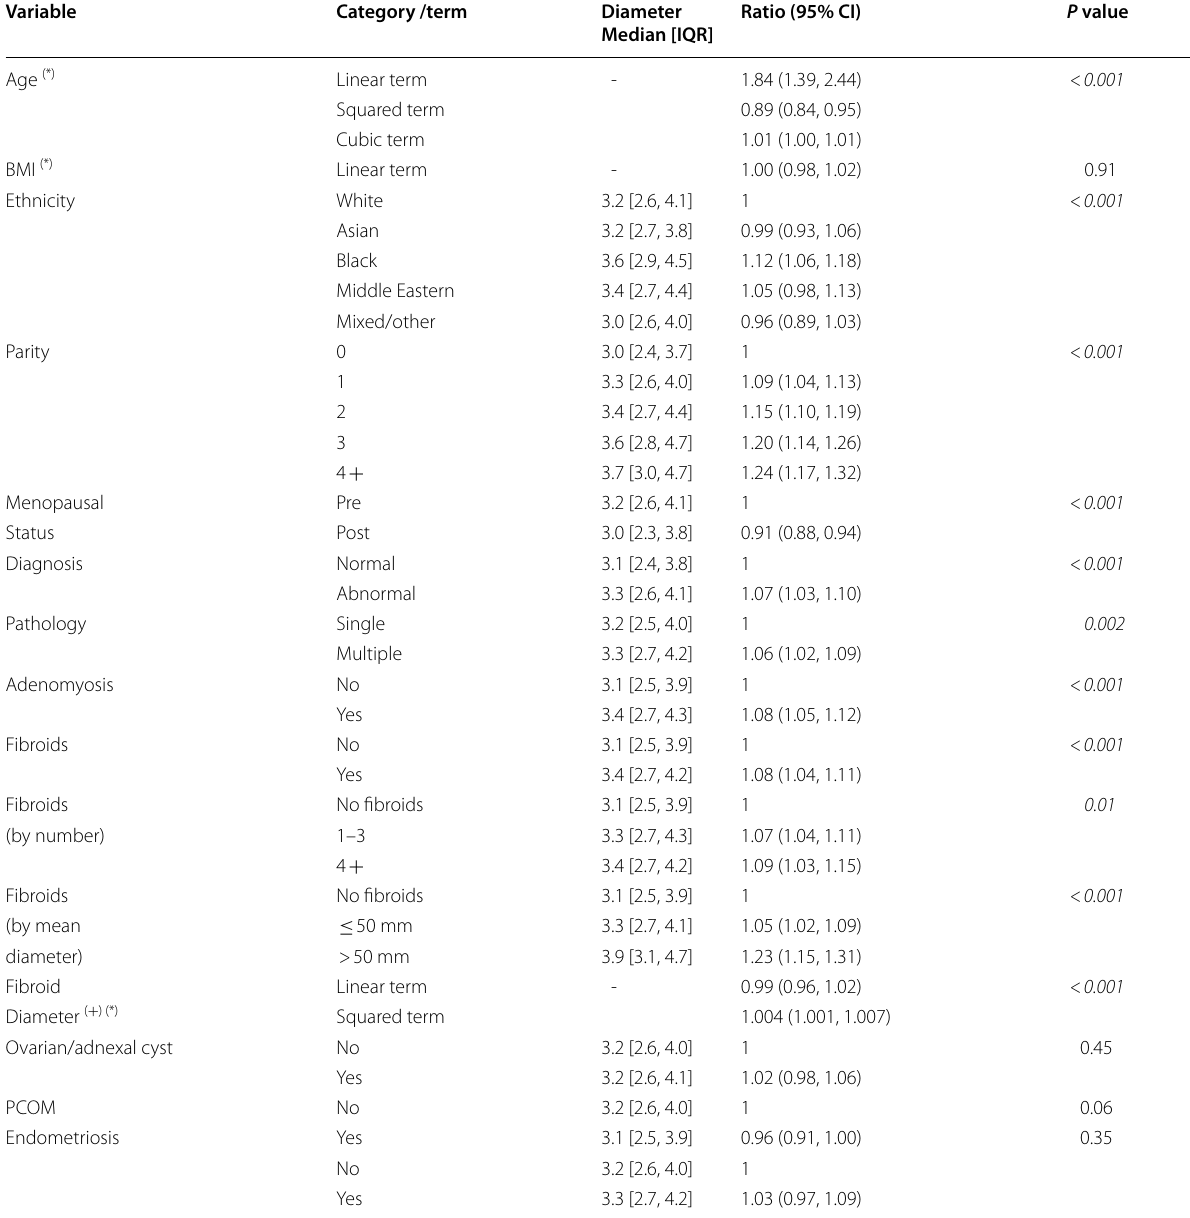
Table 5 Univariable analysis of factors affecting uterine venous diameter ( N